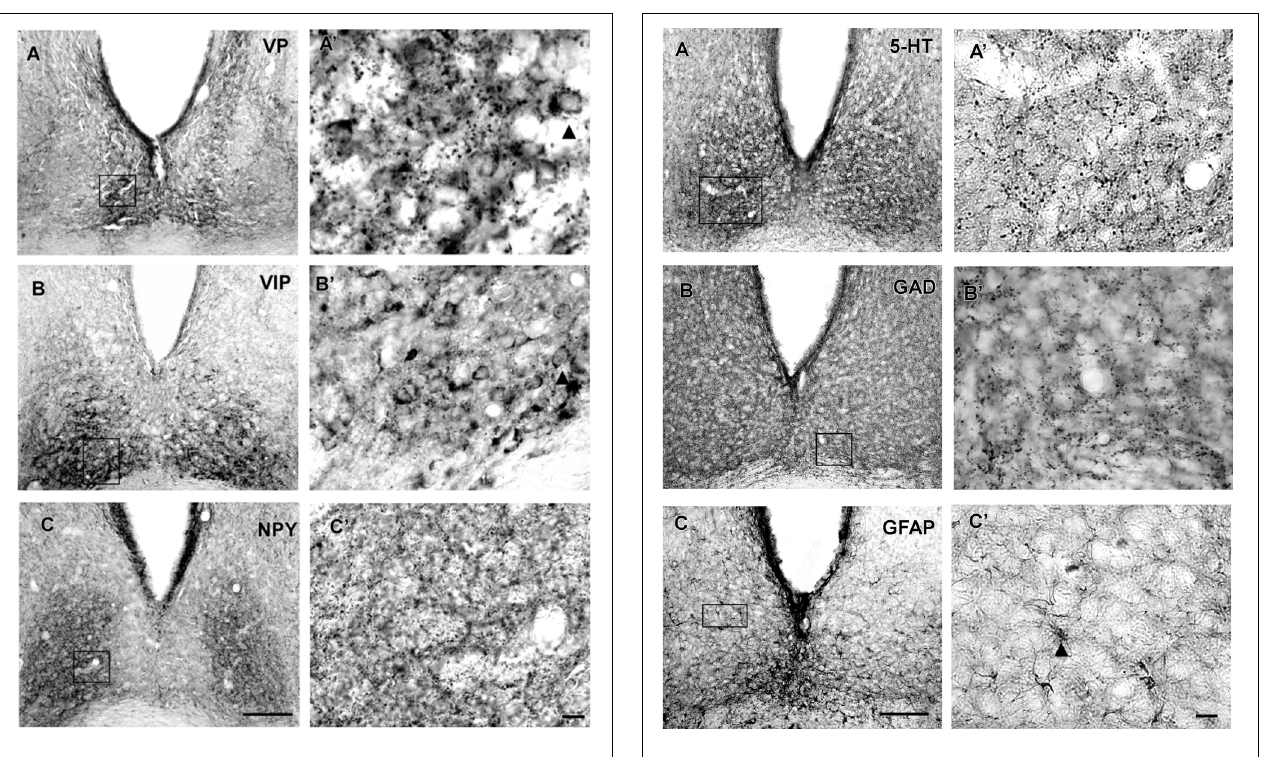
FIGURE 4 | Photomicrographs of SCN coronal sections showing the immunoreactivity pattern against 5-HT (A,A’) , GAD (B,B’) at the middle level, and GFAP at the middle level (C,C’) . Black arrowheads point to GFAP-IR cells. oc, optic chiasm; 3v, third ventricle; SCN, suprachiasmatic nucleus. Scale bar 100 µ m (A–C) and 10 µ m (A’–C’)